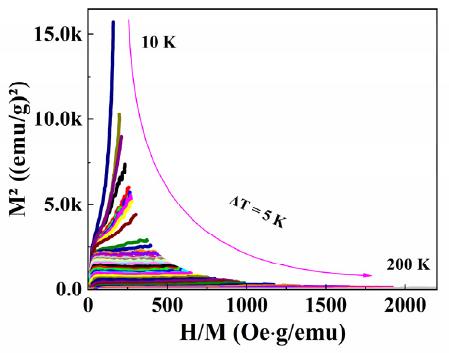
Figure 7. The Arrott plot obtained from the isothermal magnetization.